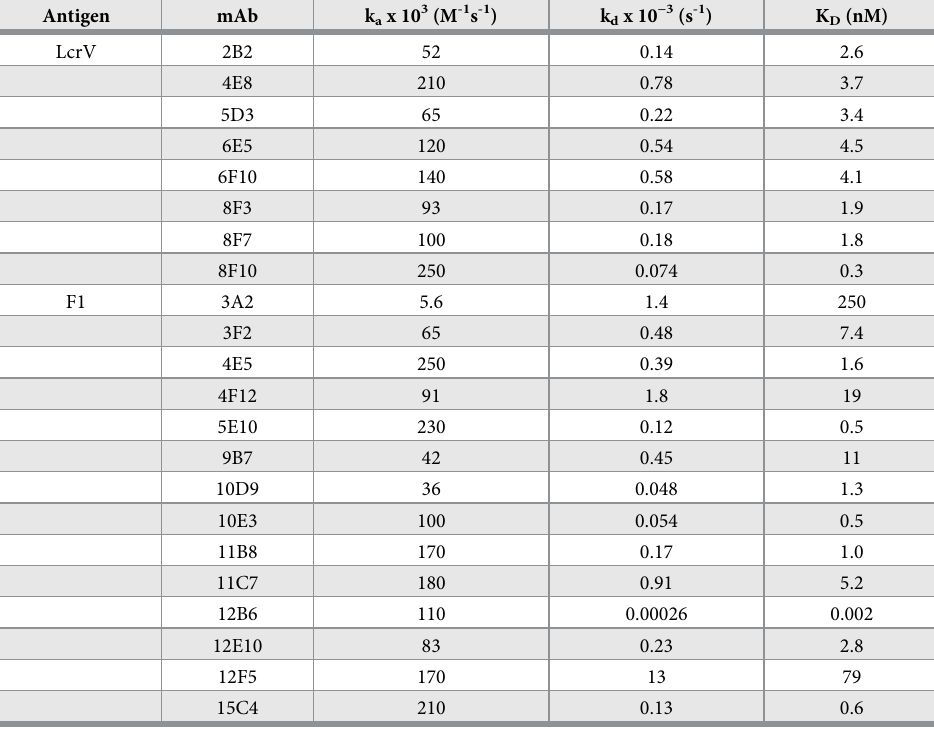
Table 2. Affinity and kinetics analysis of Y . pestis mAbs by surface plasmon resonance.